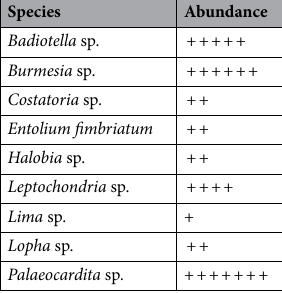
Table 1. Species richness of bivalve fossils in the Sêwa Formation of the Rigenco section in the northeastern Riganpeicuo area, Tibet.